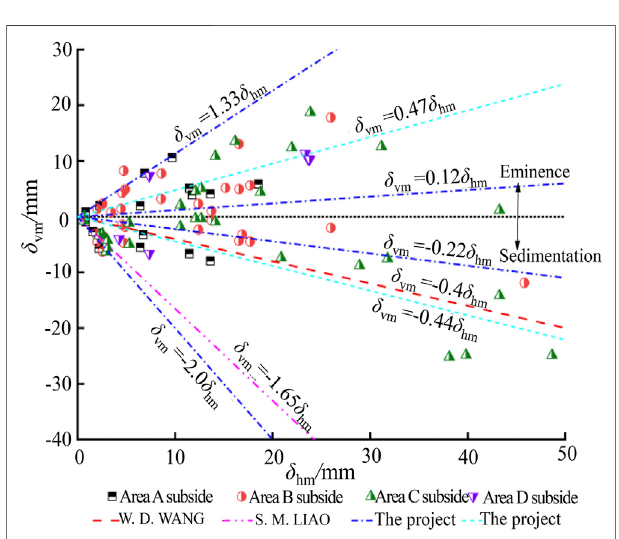
FIGURE 9 | Relationship between δ hm and δ vm